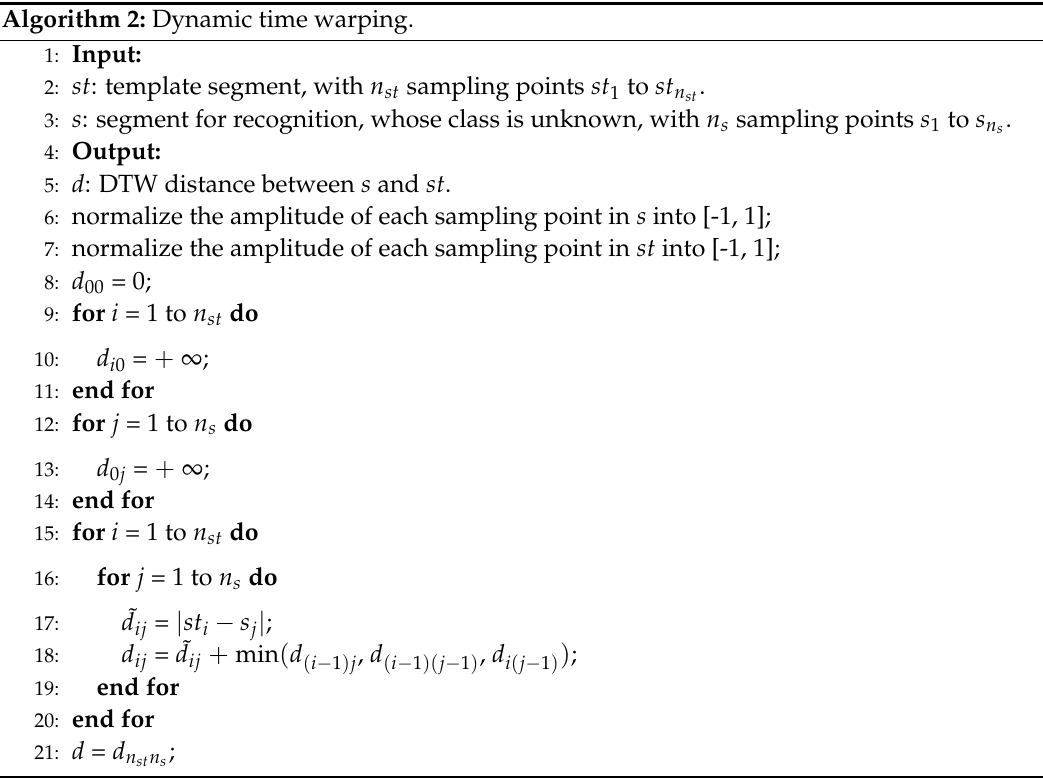
Algorithm 2: Dynamic time warping.